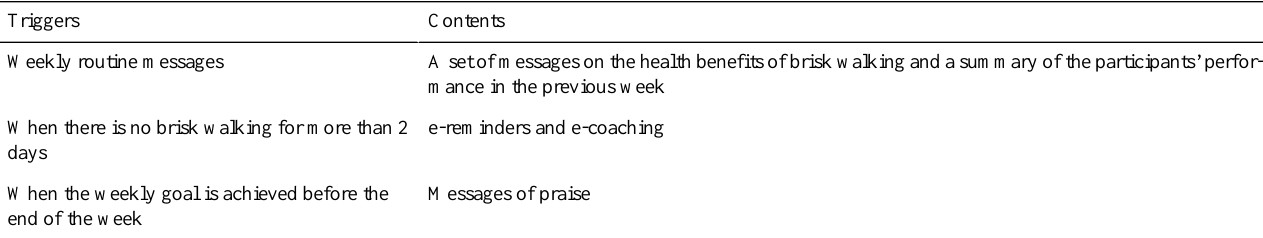
Table 4. Description of the tailored strategies by contacting the participants in the mHealth